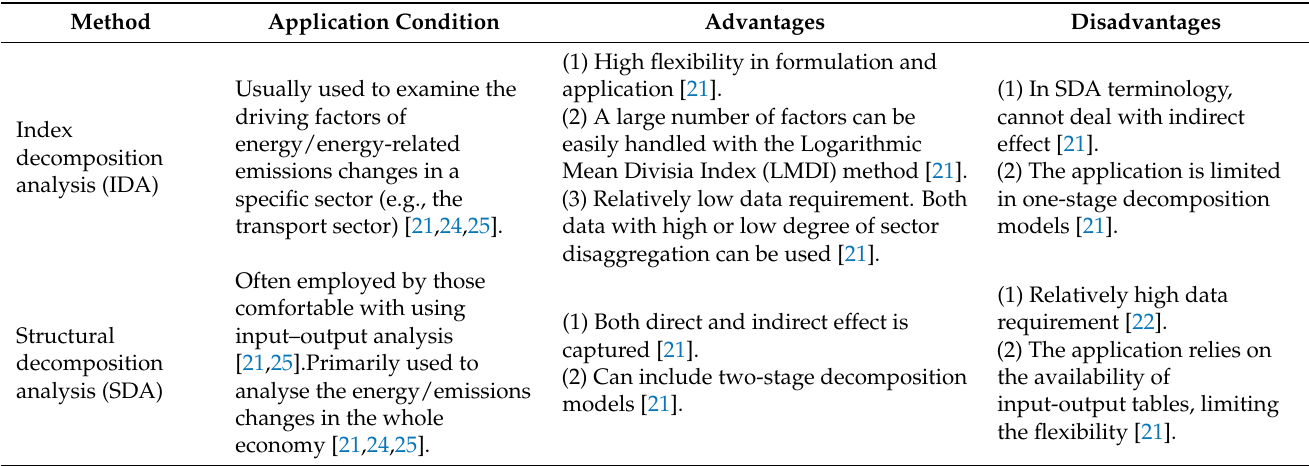
Table 2. Advantages and disadvantages of the IDA and SDA